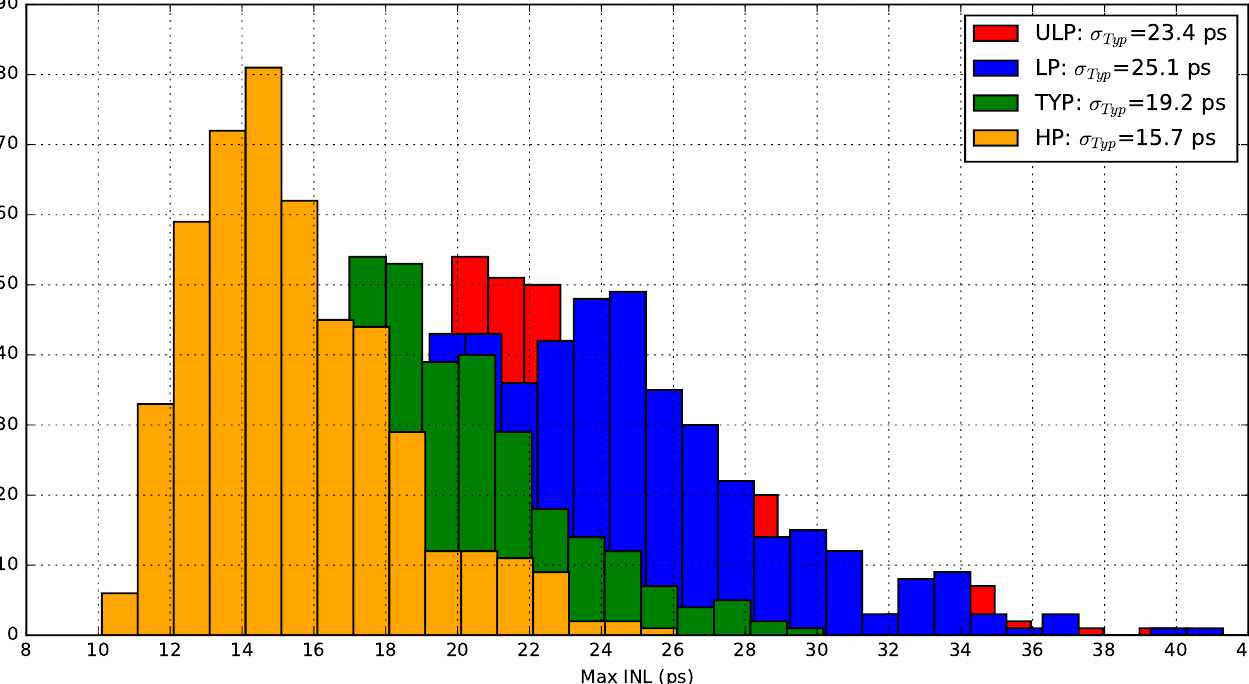
Figure 12. Maximum INL for each MATRIX16 channel sample (without calibration).